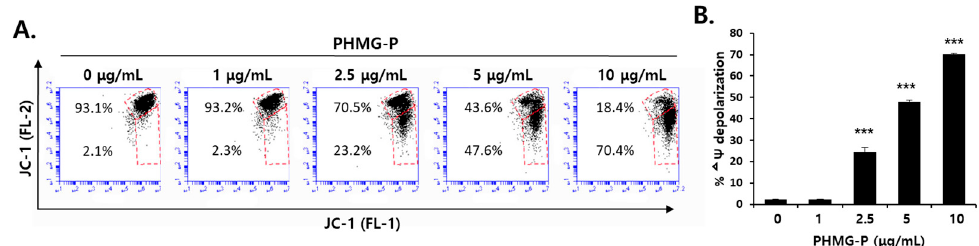
Figure 3. The induction of mitochondrial dysfunction in HepG2 cells treated with PHMG-P. ( A ) The cells were treated with increasing concentrations of PHMG-P for 16 h prior to FACS analysis of JC-1 staining. ( B ) Quantification of mitochondrial membrane potential ( ∆Ψ ) from three independent experiments. Each value represents the mean ± SD. (** * p < 0.001, compared with untreated cells). PHMG-P also activated the apoptotic signaling pathway in a concentration-dependent manner.